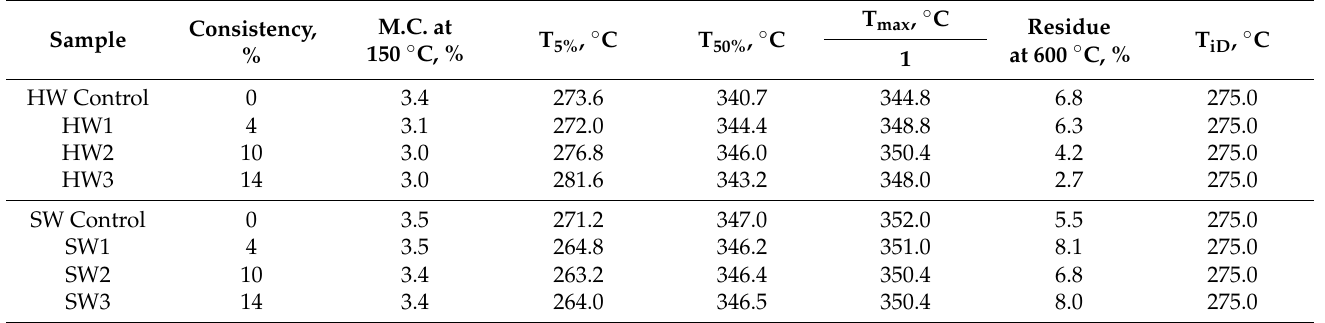
Table 7. Summary of TGA data of untreated and oxidized HW and SW pulps.